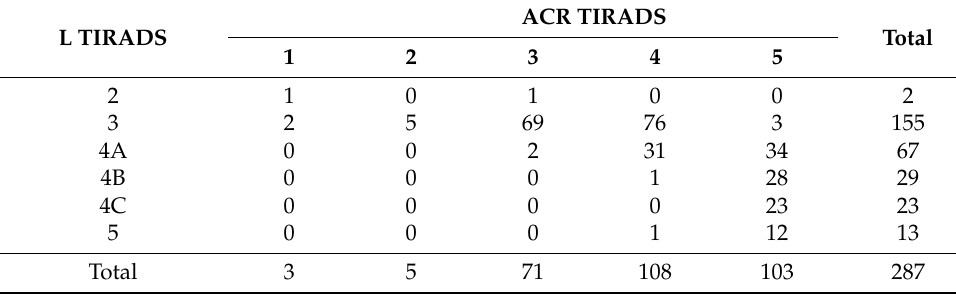
Table 10. Comparison between the L -TIRADS and ACR-TIRADS